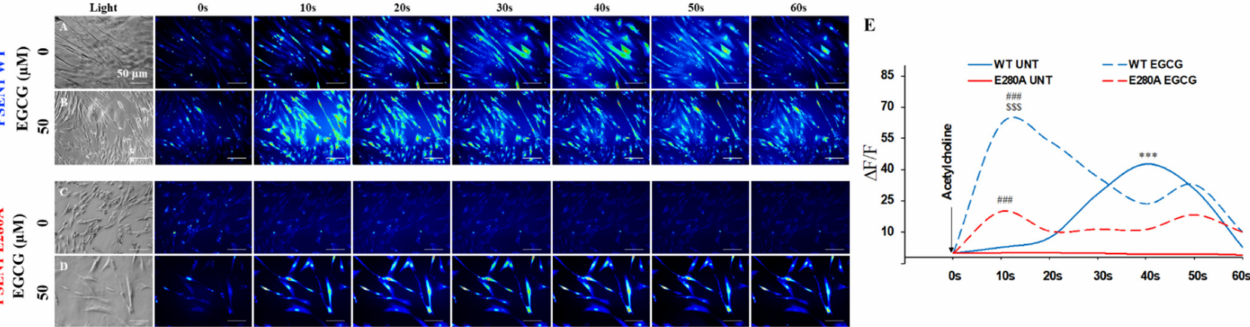
Figure 6. EGCG recovers Ca 2+ dysregulation in PSEN1 E280A ChLNs. After 7 days of transdifferentiation, WT PSEN1 and PSEN1 E280A ChLNs were left untreated or treated with EGCG in a regular culture medium for 4 days. ( A – D ) Time-lapse images (0, 10, 20, 30, 40, 50, and 60 s) of Ca 2+ fluorescence in WT PSEN1 and PSEN1 E280A ChLNs on day 4 in response to ACh treatment. ACh was puffed into the culture at 0 s (arrow). Then, the Ca 2+ fluorescence of the cells was monitored at the indicated times. Color contrast indicates fluorescence intensity: dark blue < light blue < green < yellow < red. ( E ) Normalized mean fluorescence signal ( ∆ F/F) over time from the cells indicating temporal cytoplasmic Ca 2+ elevation in response to ACh treatment. Data are presented as the mean ± SD. *** , ###, $$$ p < 0.001; *** represents differences compared to UNT PSEN1 E280A cells; ### represents differences compared to UNT PSEN1 WT or E280A cells; $$$ represents differences compared to EGCG-treated PSEN1 E280A cells. The figures represent 1 out of 3 independent